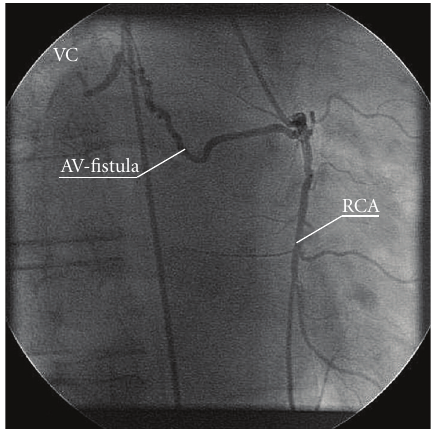
Figure 2: Arteriovenous fistula originating from the right coronary artery and draining into the vena cava. VC = vena cava. RCA = right coronary artery. AV =